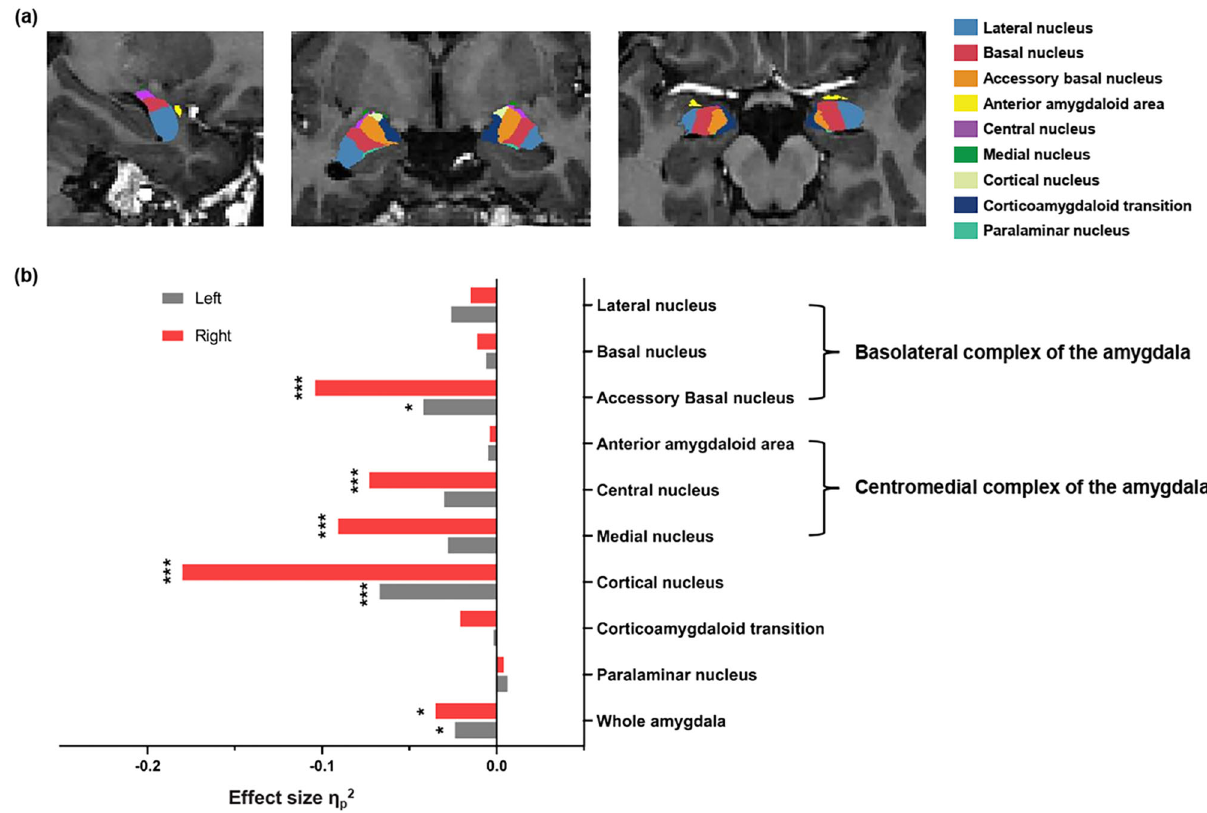
Fig. 3 Amygdala subregional volume in OCD and HC. a An example of amygdala segmentation in a healthy control subject. b Effect size for the left (gray) and right (red) amygdala nuclei. Positive effect size indicates larger volume in obsessive-compulsive disorder (OCD) group compared to healthy control (HC) group, and negative effect size indicates smaller volume in OCD group compared to HC group. Signi fi cance is indicated for false discovery rate – corrected * p < .05; ** p < .01; *** p < .005. n = 182 biologically independent samples were used to derive